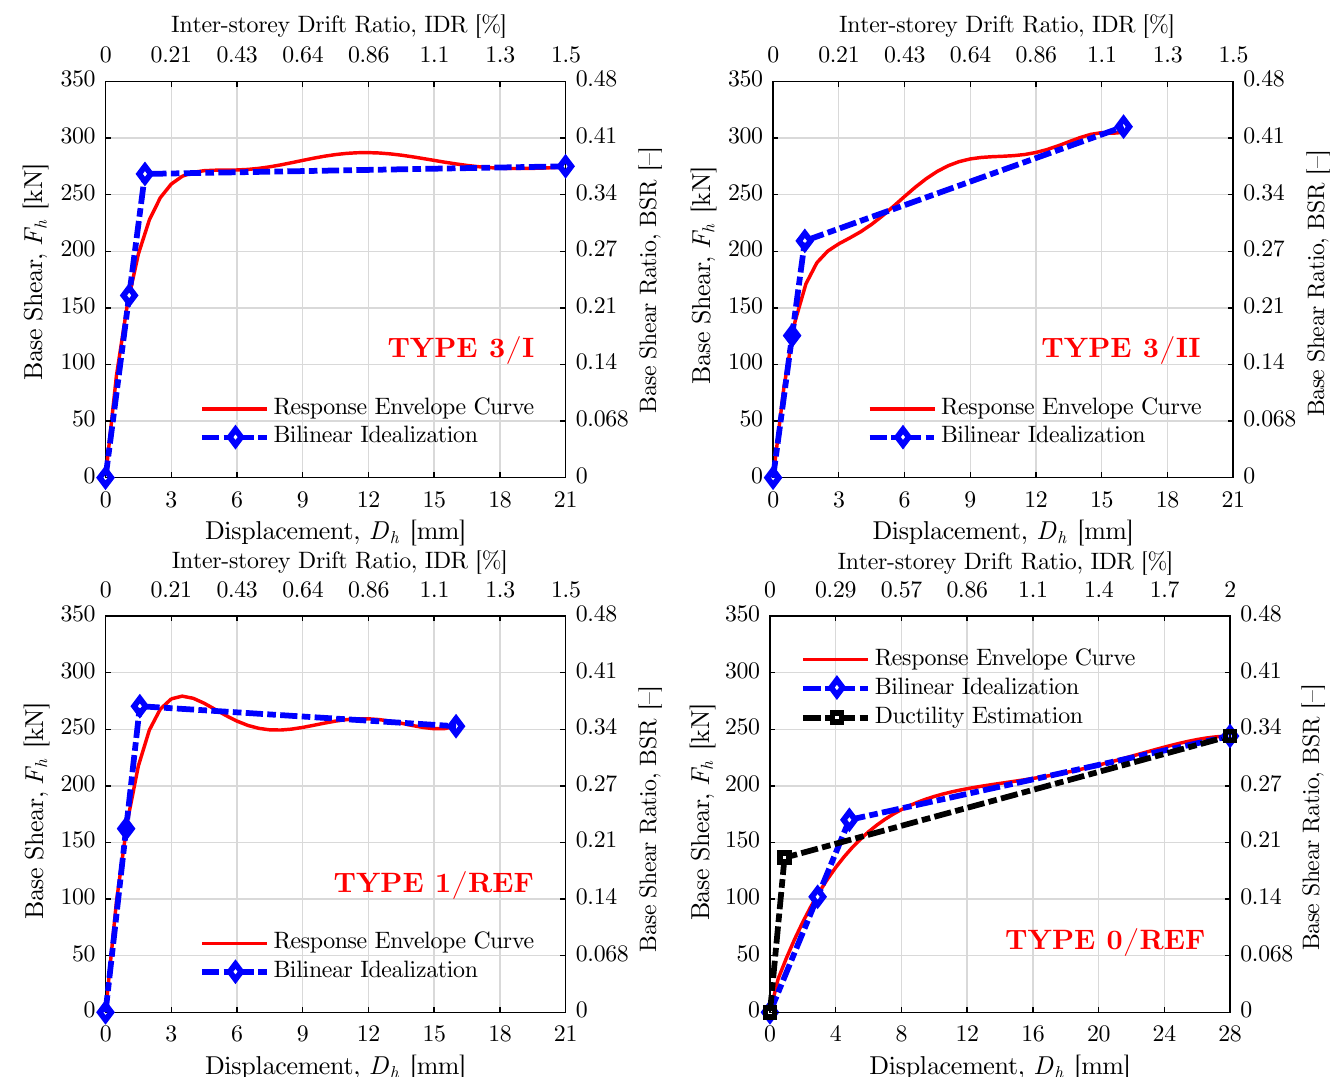
Figure 10. Bilinear idealisation of the response envelope curves for reference and TYPE 3